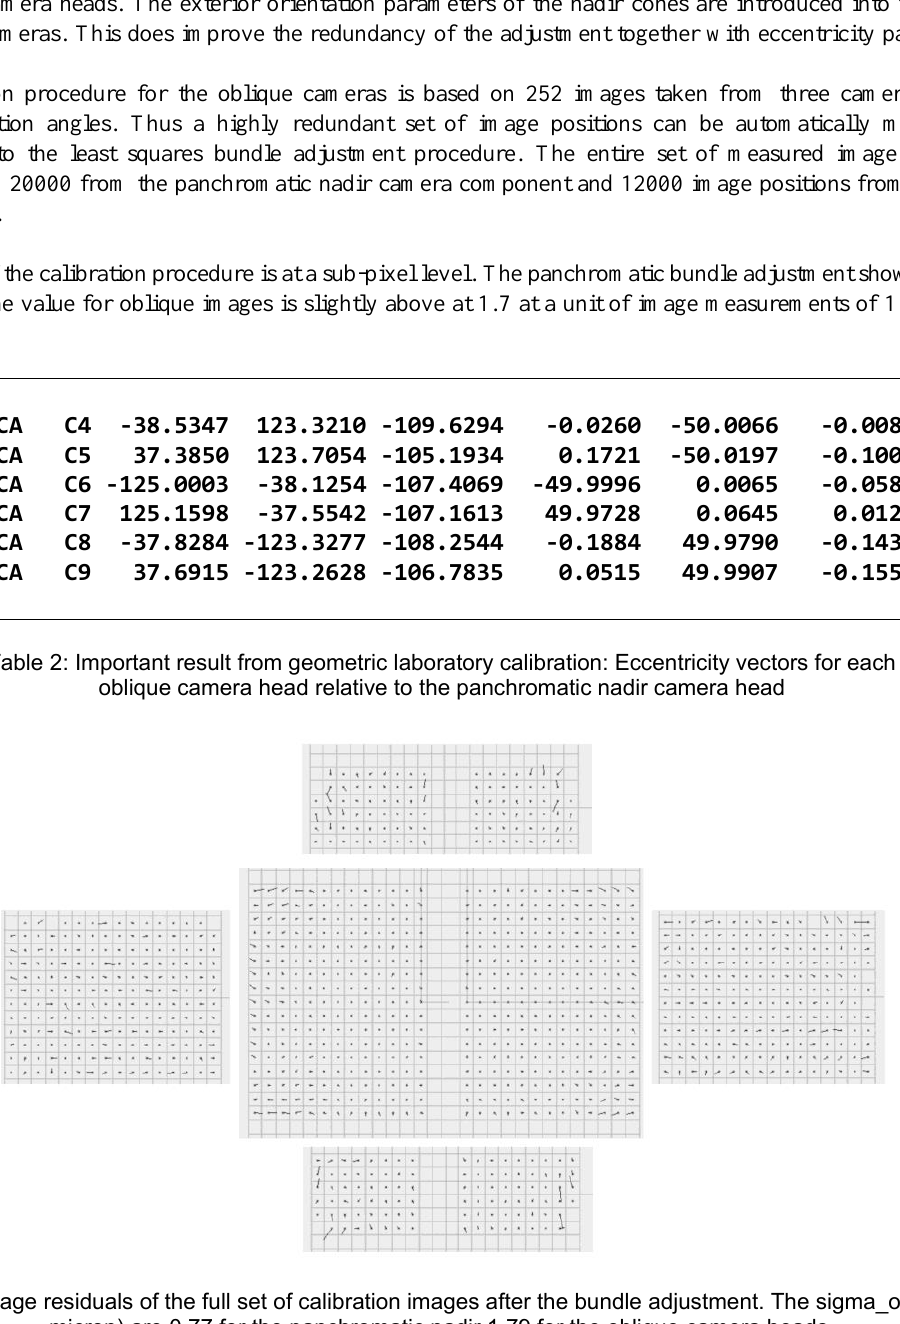
Figure 3: Image residuals of the full set of calibration images after the bundle adjustment. The sigma_o values (in micron) are 0.77 for the panchromatic nadir 1.79 for the oblique camera